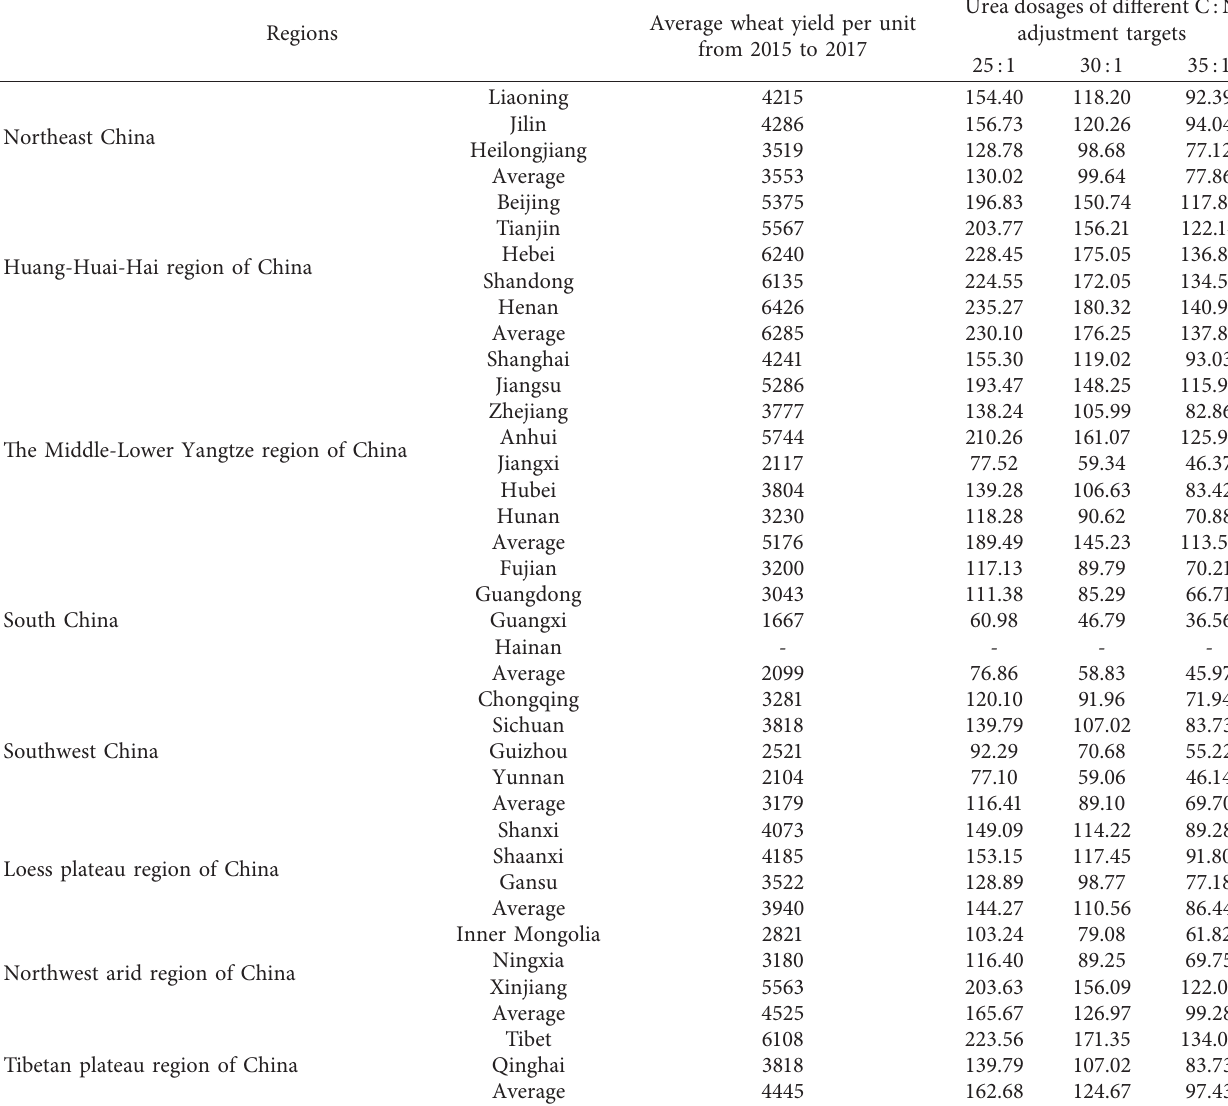
Table 5: Enquiry table for urea applied to wheat straw returning to the field in all regions of China and provinces (cities, autonomous